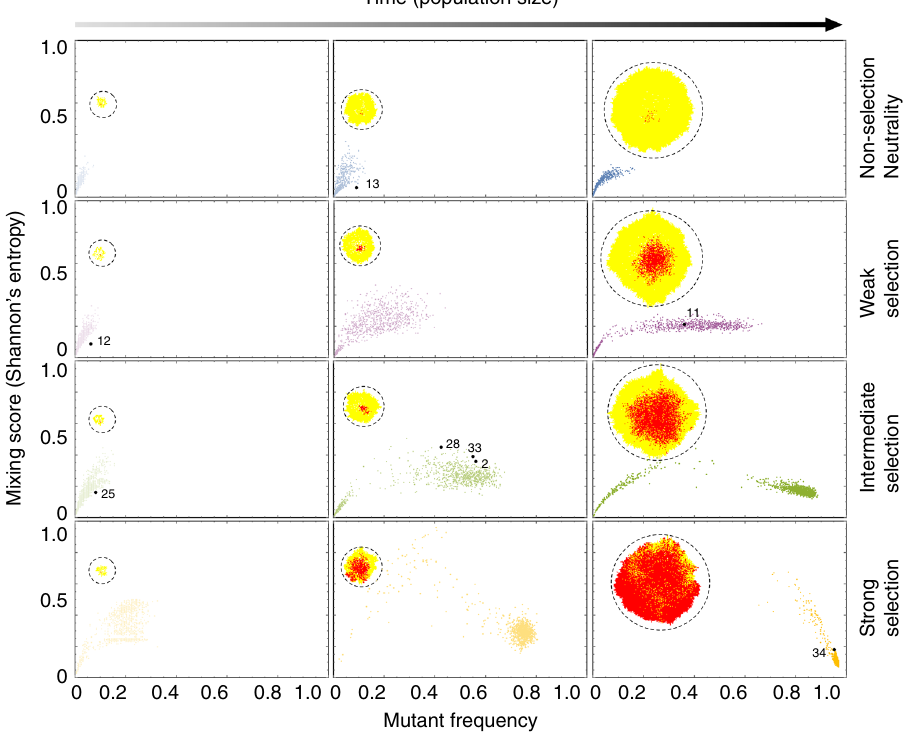
Fig. 4 Inference of subclone evolutionary dynamics. Computational modeling predicts the relationship between clone intermixing and clone size, and the time of clone appearance and selective advantage. Clone mixing level increases to a transient high at intermediate times as the subclone expands, and decreases as the clone takes over the tumor or is lost (time increases along the columns). The strength of selection experienced by the subclone determines the speed and maximal extent of subclone mixing (selection increases down the rows). Black dots are empirically measured mixing values in primary tumors, and are plotted for the parameter values that explain the data with maximum posterior probability (see Methods). The inner panels (dashed circles) are representative simulation snapshots indicating the expected clonal intermixing. Each panel shows results from 1000 independent realizations; relative growth ratios of the mutant to wild type are 1, 1.75, 3.0, 8.0 for neutral, weak, intermediate, and strong selection, respectively; the initial mutant frequency is 0.01 and the fi nal tumor size is 10